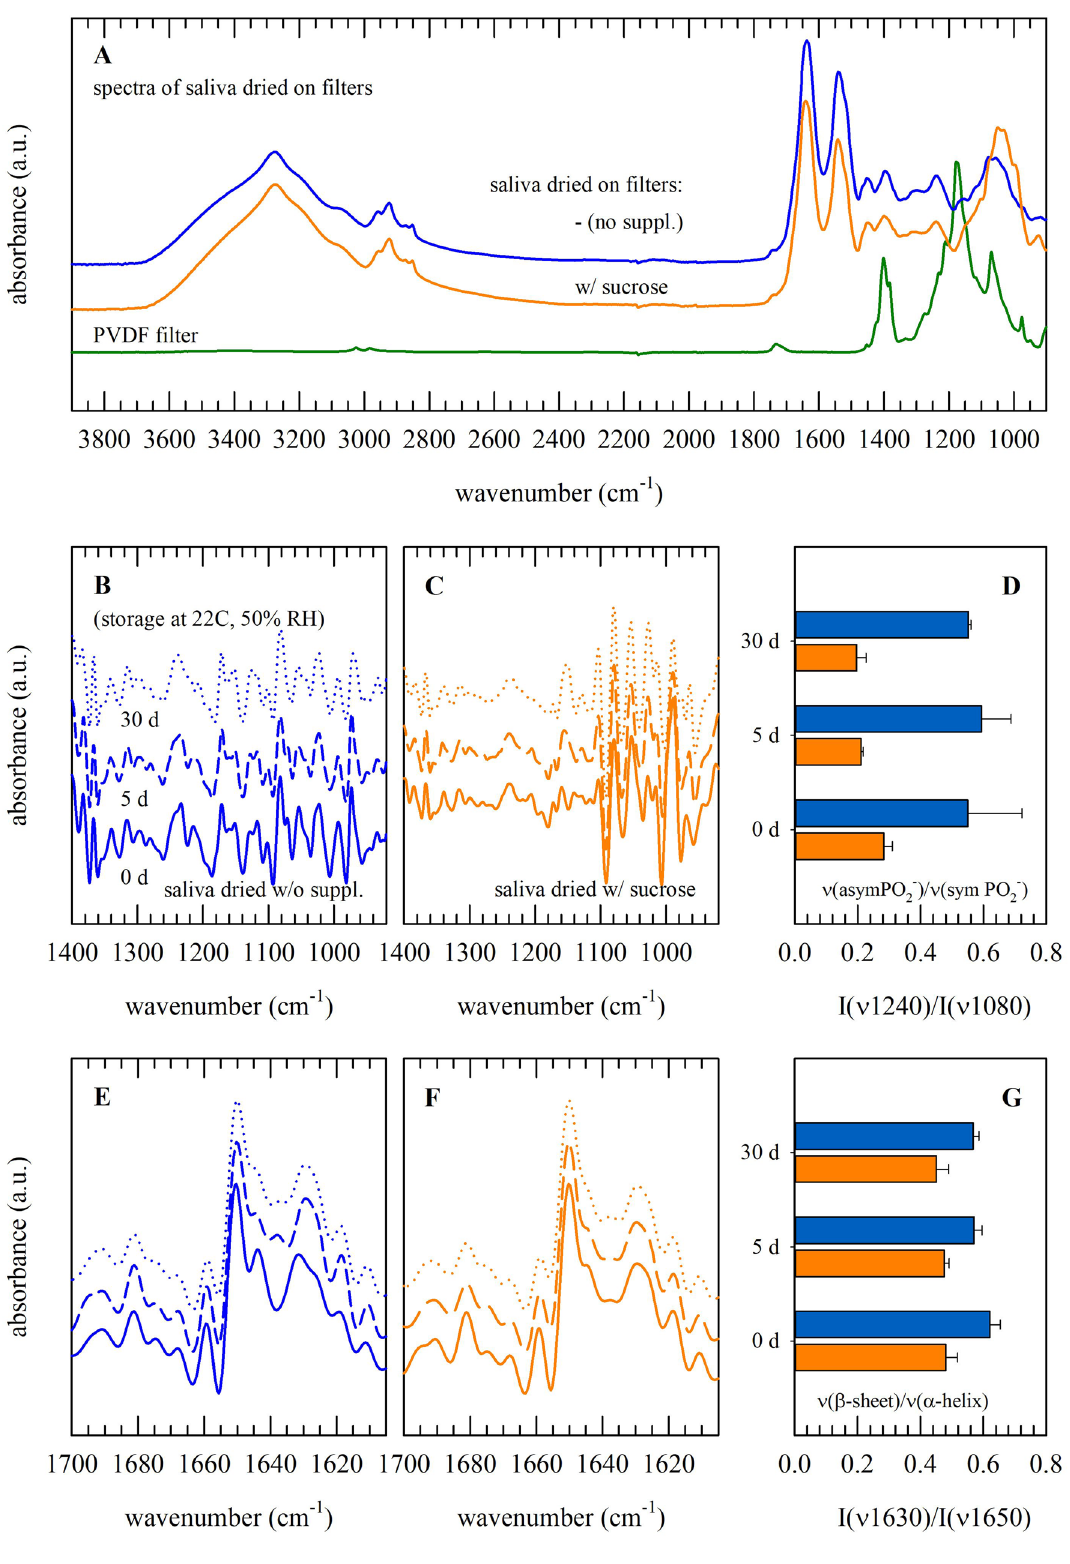
Figure 4. FT-IR spectral analysis of saliva dried on filters. Spectra were collected for PVDF filters only (green lines), as well as filters with saliva dried without protectants (blue lines and bars) or dried with 10% sucrose (orange lines and bars). Spectra were acquired directly after drying ( A ; 0 d) as well as during storage at ambient conditions ( B – G ; 0 d, 5 d and 30 d). Full original spectra are presented ( A ) as well as normalized second derivative spectra of the fingerprint ( B , C ) and amide-I ( E , F ) regions. For depicting possible differences amongst samples, specific absorbance band intensity ratios were calculated. These included ratios for the asymmetric versus symmetric PO2- stretching vibration bands [D; I(v1240)/I(v1080)], and the β-sheet versus α-helical structure bands [G; I(v1630)/I(v1650)]. Pooled saliva was used from three different donors. Measurements were performed in triplicate, and mean values ± standard deviations are